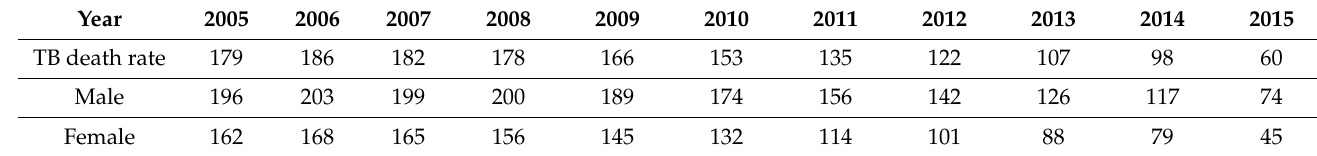
Table 1. Tuberculosis death rates per 100,000 population by year and gender in South Africa, 2005–2015.